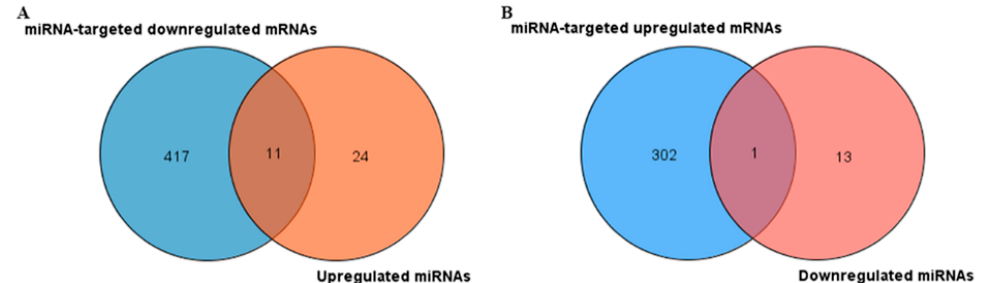
Figure 3. Identification of miRNAs involved in mRNA regulation. ( A ) Thirty-five upregulated miRNAs were identified, 11 of which led to the downregulation of target DEGs. ( B ) Fourteen downregulated miRNAs were identified, only one of which led to the upregulation of target